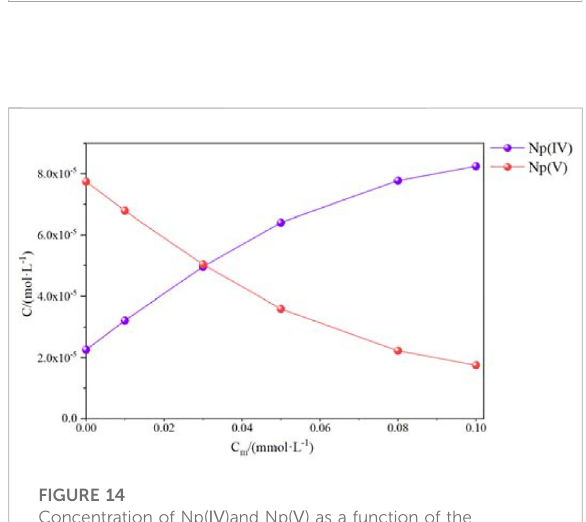
FIGURE 14 Concentration of Np( Ⅳ )and Np( Ⅴ ) as a function of the magnetite